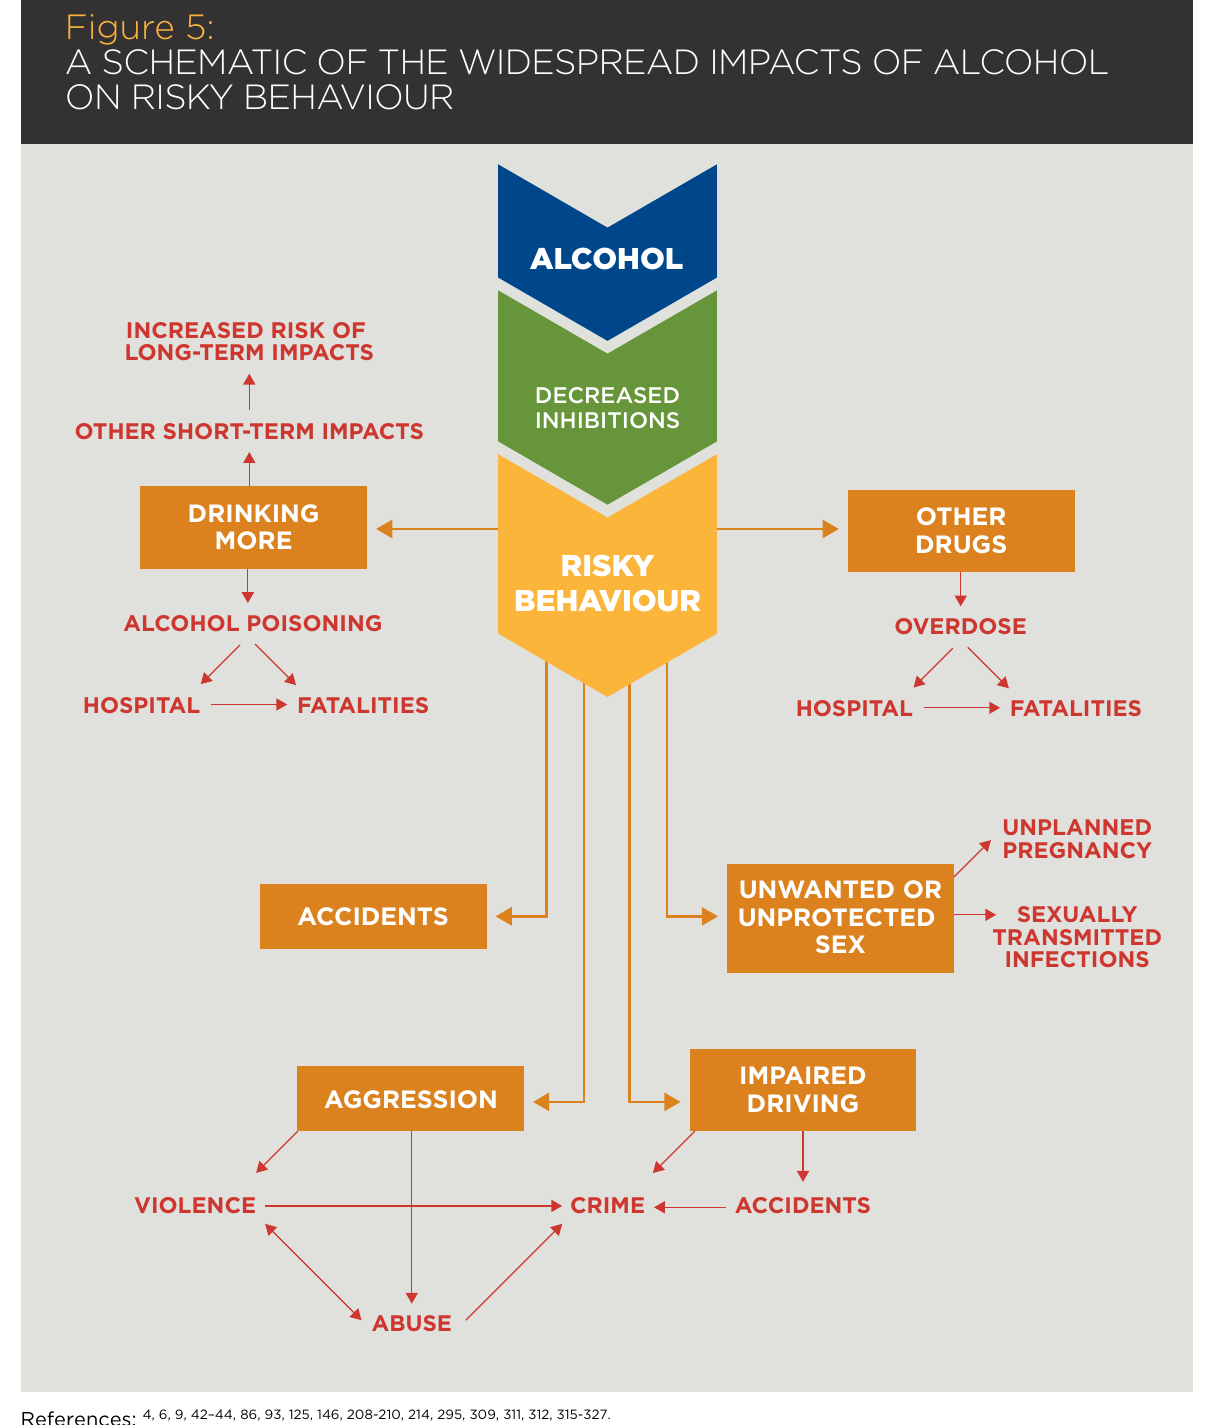
Figure 5: A SCHEMATIC OF THE WIDESPREAD IMPACTS OF ALCOHOL ON RISKY